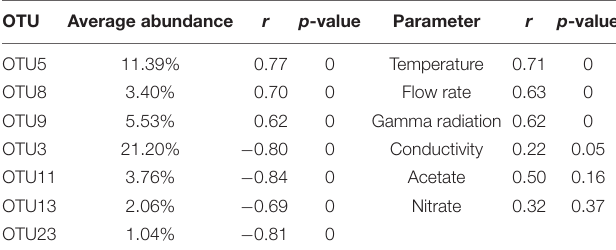
TABLE 3 | Summary of Spearman rank correlation analysis performed on Operational Taxonomic Units (OTUs) and physico-chemical parameters represented on the Non-metric Multidimensional Scaling (NMDS)